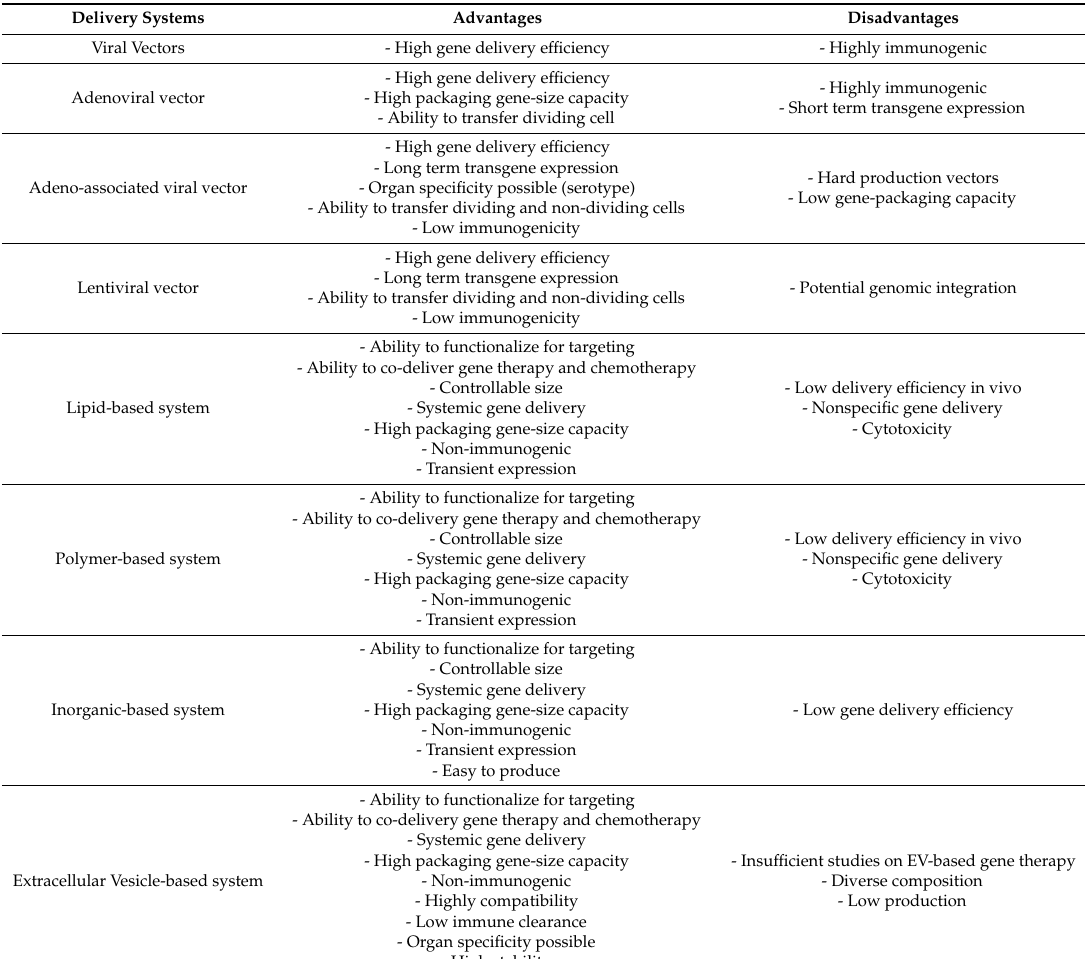
Table 2. Advantages and Disadvantages of MicroRNA therapeutic Delivery